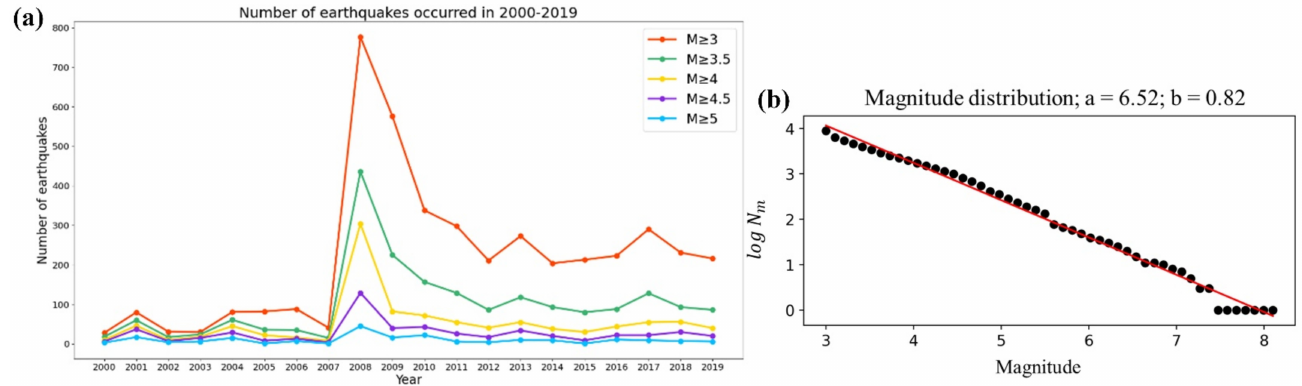
Figure 2. ( a ) The number of earthquakes that occurred from 2010 to 2019; affected by the 2008 Wenchuan earthquake, the frequency of earthquakes in that year increased significantly. ( b ) The completeness examination of the earthquake